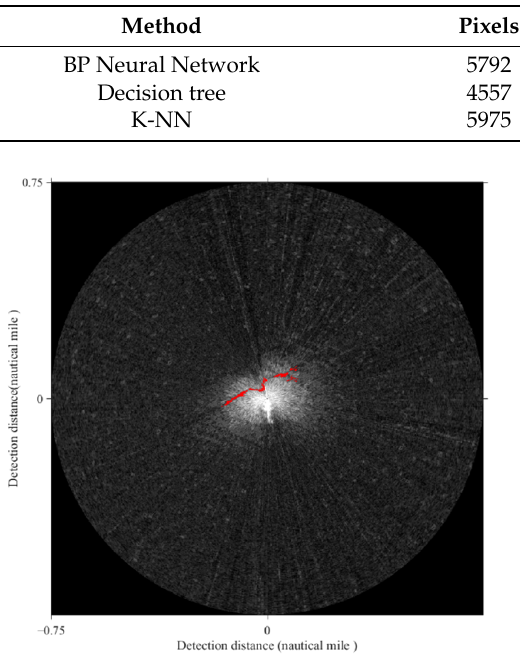
Figure 11. The oil films results: ( a ) BP neural network; ( b ) K-Nearest Neighbor; ( c ) Decision Tree. Table 5. Oil spills area.